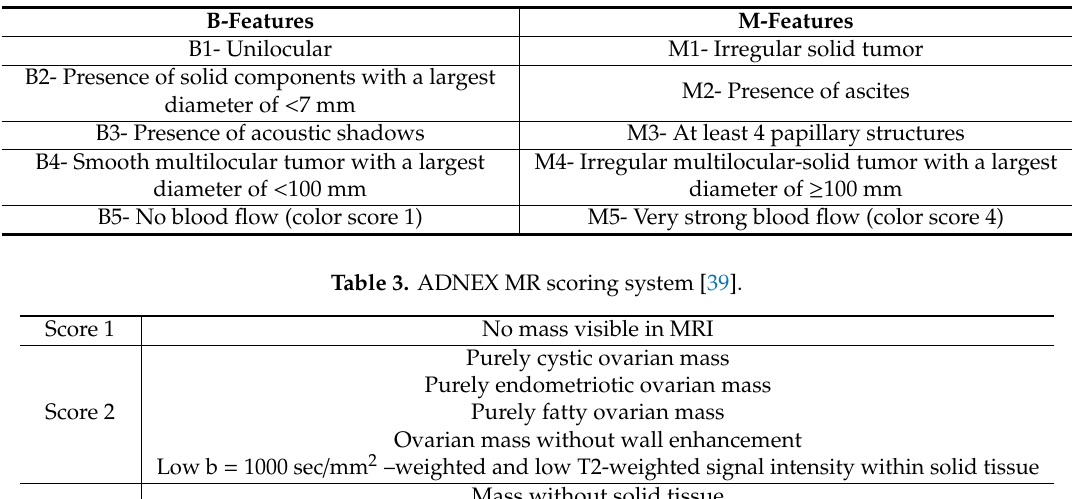
Table 2. Adnexal masses in pregnancy: benign versus malignant features (International Ovarian Tumor Analysis (IOTA) Group Simple Rules) [32].